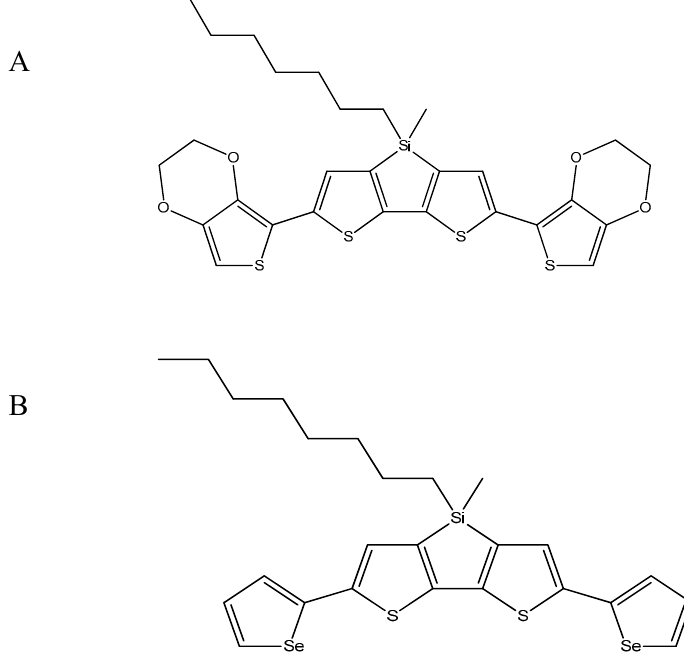
Figure 1. Structure of 2,6-bis(3,4-ethylenedioxythiophen-5-yl)-4-methyl-4-octyl-dithienosilole ( A ) and 2,6-bis(selenophen-2-yl)-4-methyl-4-octyl-dithienosilole ( B